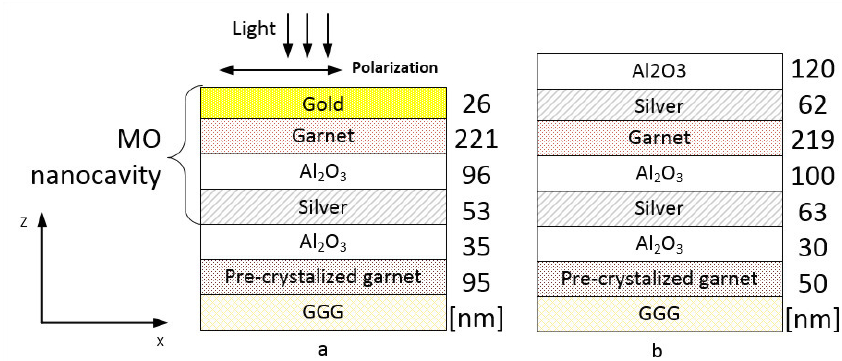
Figure 1. The schematics of the structure with: Buried Ag layer and Au layer on top ( a ), buried Ag layer and Ag, Al O layers on top ( b ). For each sample thicknesses of the 2 3 constitutive layers differ slightly. The numbers on the right side of each panel correspond to the layer thicknesses of ( a ) the sample-3 and ( b ) the